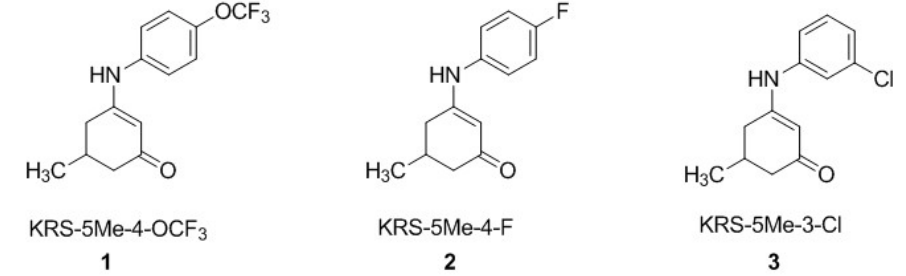
Figure 1. Monosubstituted aniline enaminones. The structural core of the analogs is the 5-methyl cyclic enaminone. The aromatic ring is monosubstituted at the para or meta position.